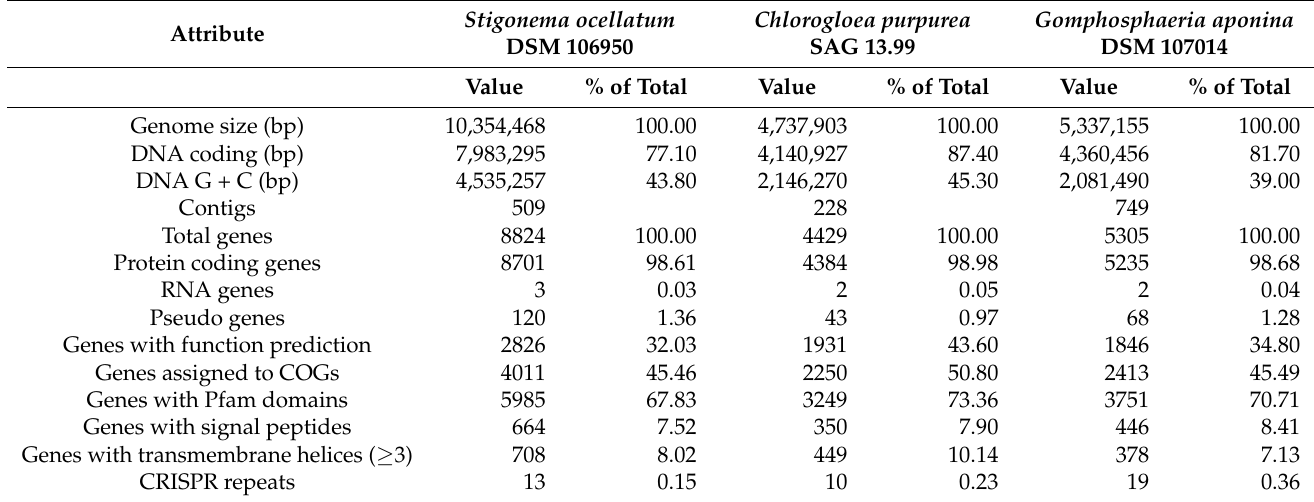
Table 2. Properties and statistics for metagenome-assembled genomes of three non-axenic cyanobacteria. The MAGs are deposited at the NCBI under the BioProject accession: